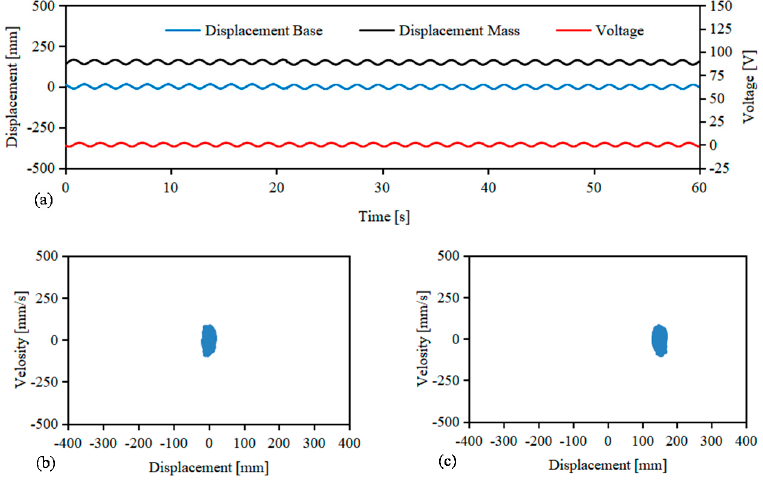
Figure 10. Measurement results of response vibration displacement and vibration power generation when vibrating with a period signal 0.5 Hz. ( a ) Results of response vibration displacement. ( b ) Diagram of displacement velocity of vibration of the support. ( c ) Diagram of displacement velocity of vibration of the mass block.